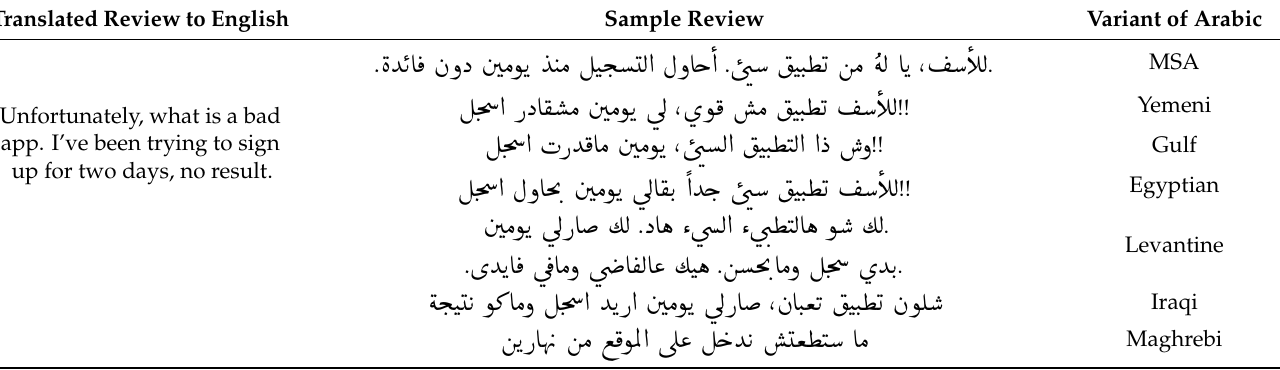
Table 5. A sample of a review written by different users with different regional